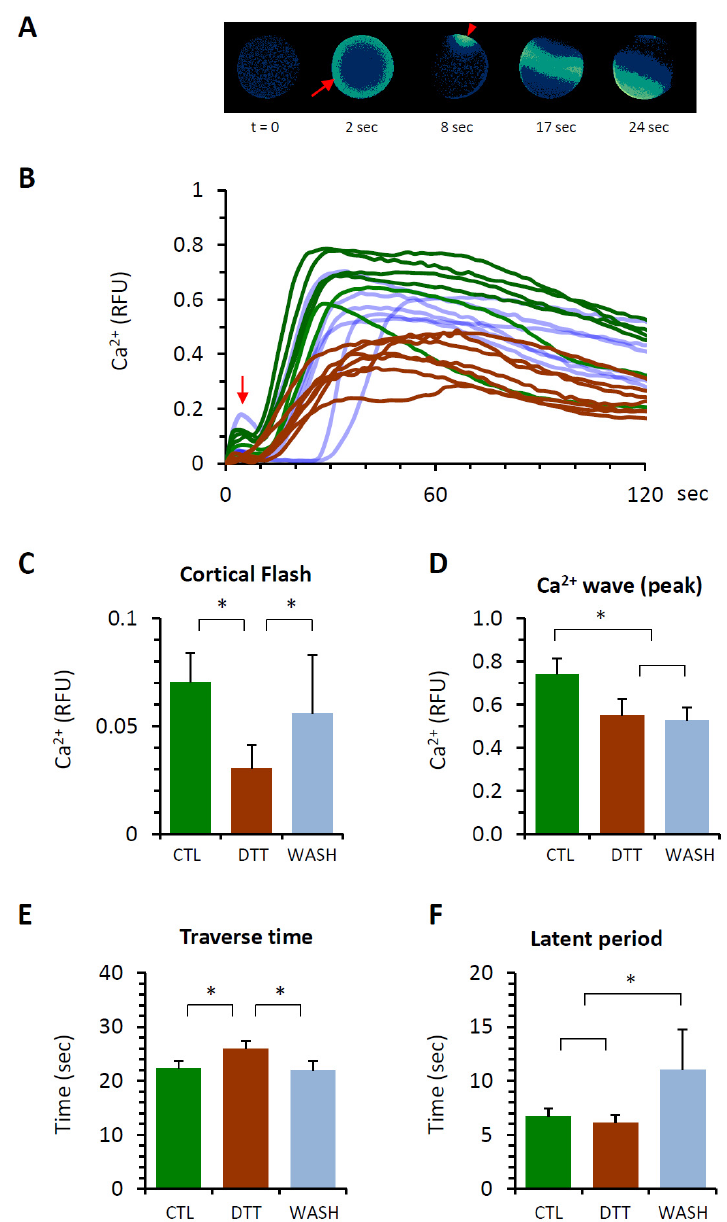
Figure 4. DTT pretreatment of the eggs alters the Ca 2+ response at fertilization. P. lividus eggs were microinjected with calcium dye and preincubated in seawater with 10 mM DTT (10 min) prior to fertilization. As a control (CTL), eggs from the same batch were prepared in parallel and fertilized in NSW. For comparison, some eggs preincubated in the presence of 10 mM DTT were restored in normal seawater and fertilized (WASH). ( A ) Instantaneous increment of Ca 2+ signals inside a control egg visualized in pseudocolour. The time point immediately before the first detectable Ca 2+ signal was set as t = 0. The arrow indicates cortical flash (CF), and the arrowhead pinpoints the sperm interaction site on the egg where the Ca 2+ wave is initiated. ( B ) Changes of the Ca 2+ signals: green curves (CTL), brown curves (eggs fertilized in 10 mM DTT), and curves in pale blue (eggs fertilized after restoration in NSW, 10 min). The vertical arrow indicates the CF. Out of four independent experiments conducted, the result of one representative experiment was plotted for Ca 2+ trajectories. Histograms in panels C − F represent comparisons of the egg groups with respect to the CF amplitude ( C ), the peak amplitude of the Ca 2+ wave ( D ), the duration of the Ca 2+ wave traversing the egg from the sperm interaction site to the antipode ( E ), and the time interval between the CF and the initiation of the Ca 2+ wave ( F ). * Tukey’s post hoc test, p < 0.01. RFU, relative fluorescence